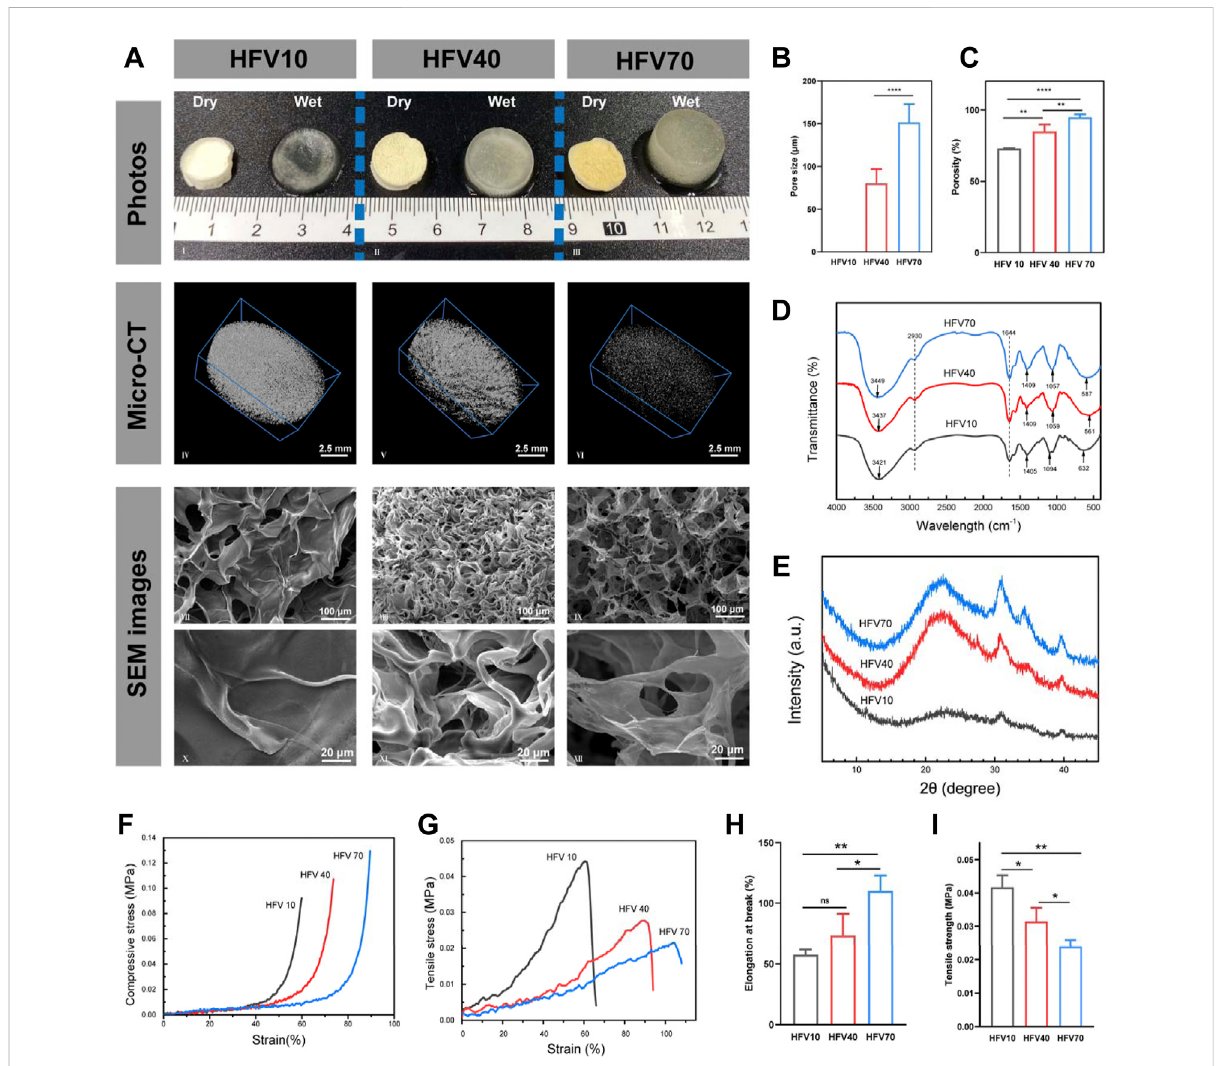
FIGURE 2 Appearance, physical characterization, and mechanical properties of HFVs. (A) Macro and micromorphology of HFVs: photographs (I – III), micro-CT images (IV – VI), and cross-sectional SEM images (VII – IX: low-magni fi cation, 300 ×; X – XII: high magni fi cation, 1500 ×). (B) Average